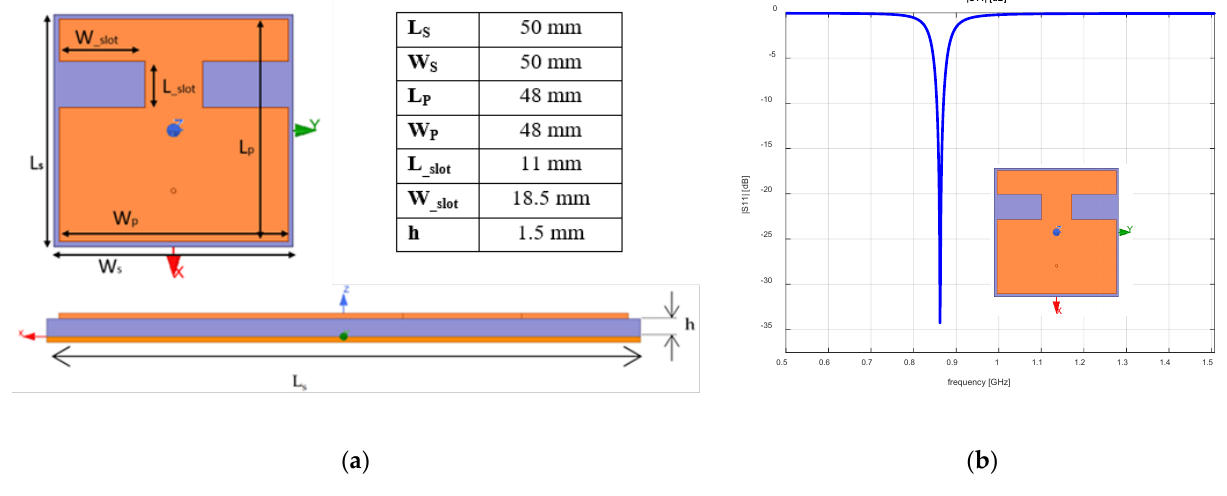
Figure 2. Antenna dimensions: ( a ) Front view and side view with dimensions; ( b ) Reflection coef- ficient.